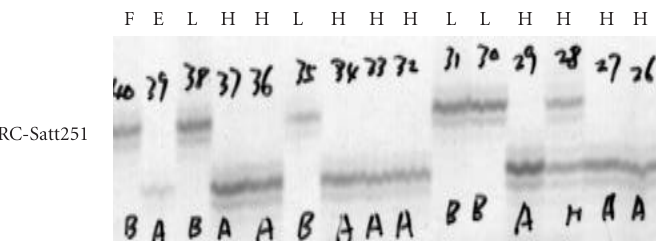
Figure 2: Autoradiograph showing PCR amplification of genomic DNA from the low glycitein Forrest (F), the high glycitein parent (E) and the F5:13 selected RIL segregating for glycitein soybean seed content with the BARC-Sat251 primers. The labeled PCR products were electrophoresed on an 5% polyacrylamide denaturing gel (H: High content, L: Low content of glycitein seed